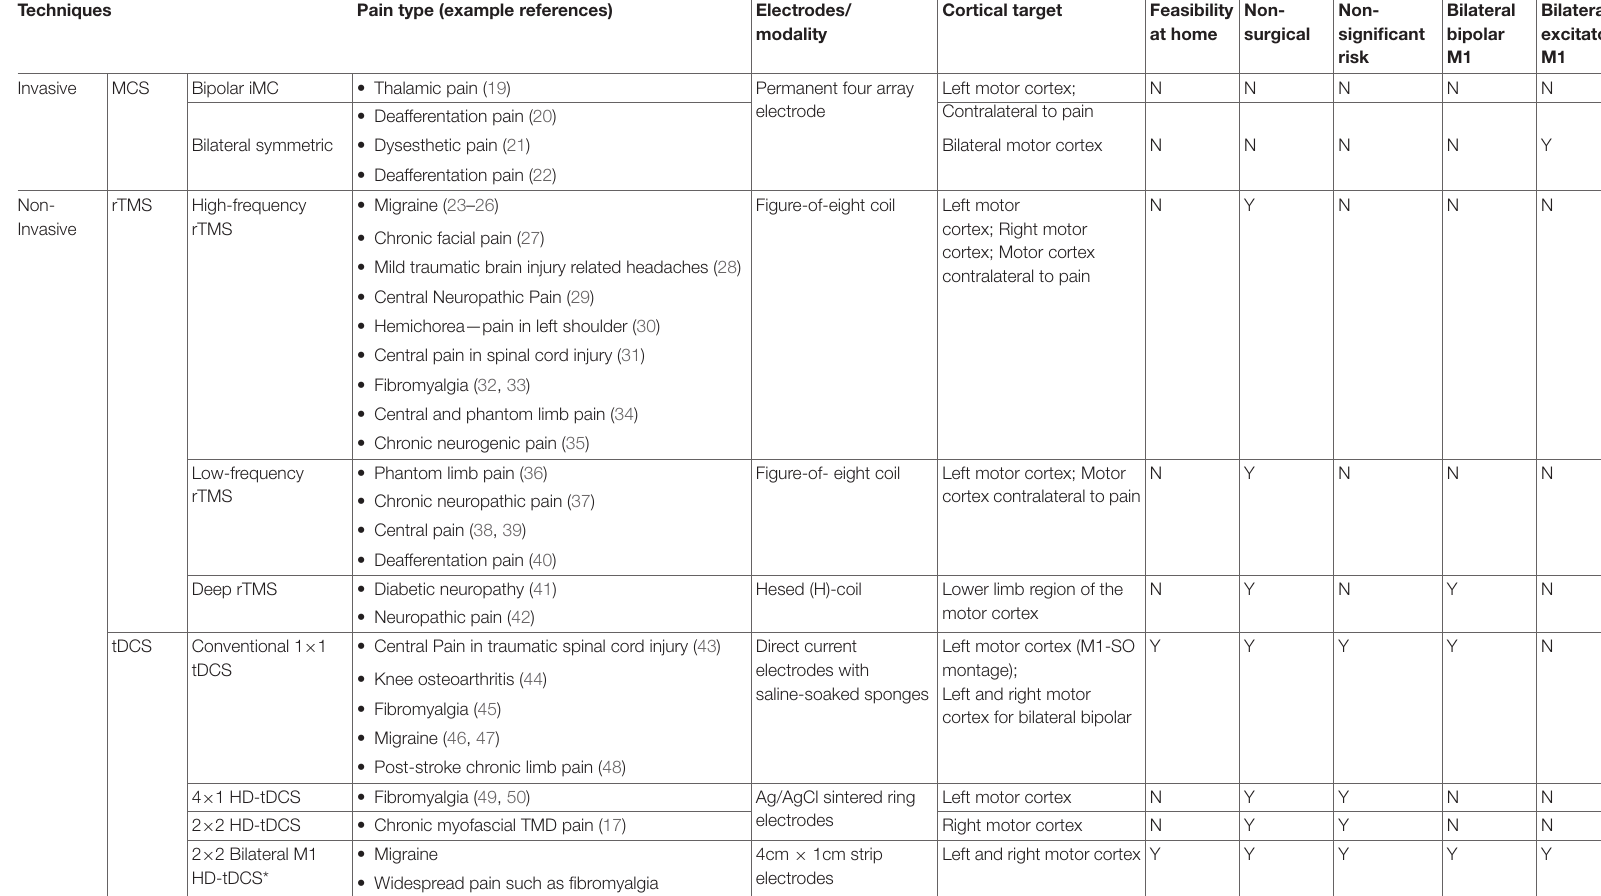
TABLE 1 | Summary of brain stimulation techniques for pain improvement targeting the motor strip. Techniques